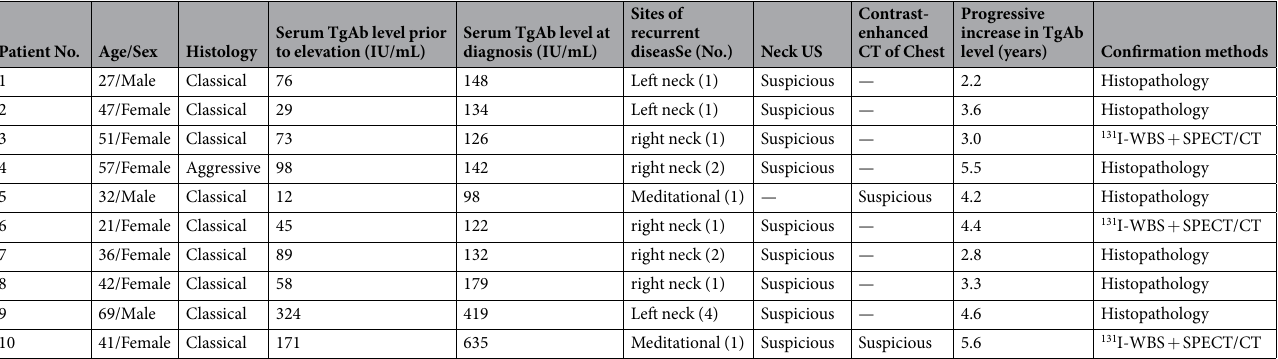
Table 3. Clinical and pathological characteristics for 10 patients with false-negative 18 F-FDG PET/CT findings.